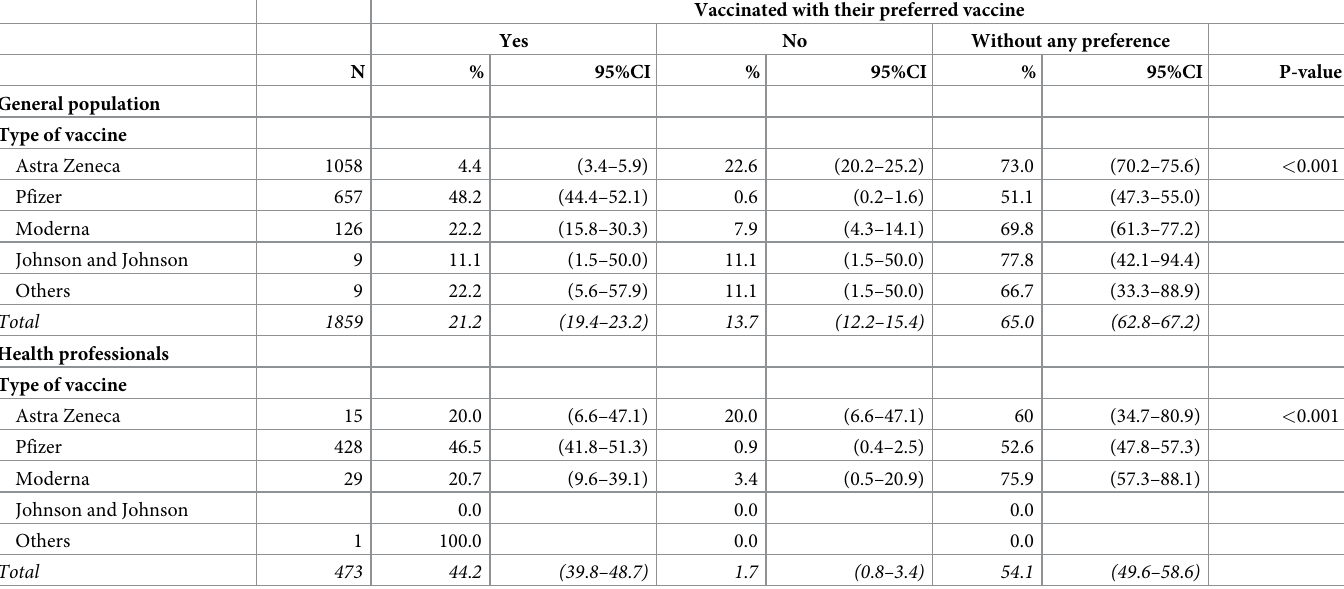
Table 3. Distribution of people vaccinated with their preferred vaccine according to the type of COVID-19 vaccine